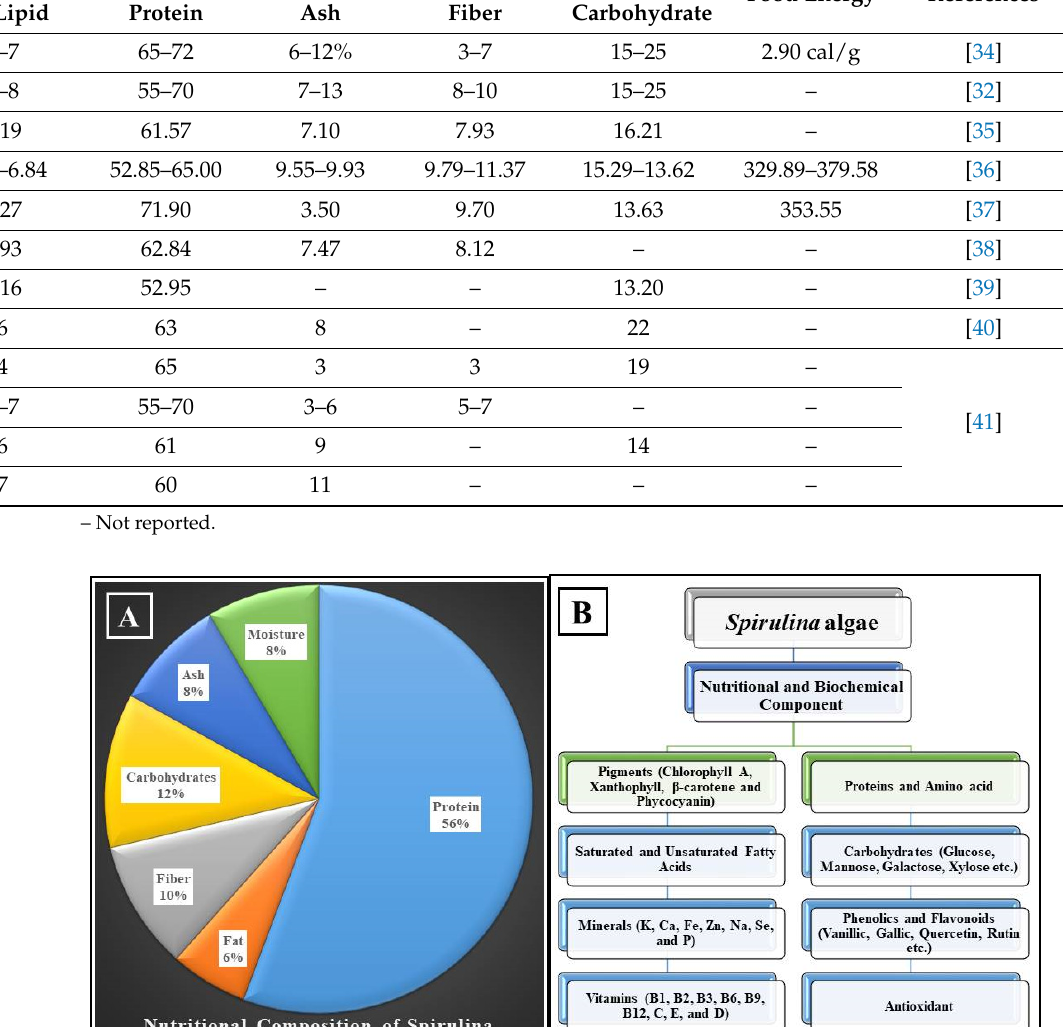
Figure 1. ( A ) Nutritional composition and ( B ) biochemical components of spirulina